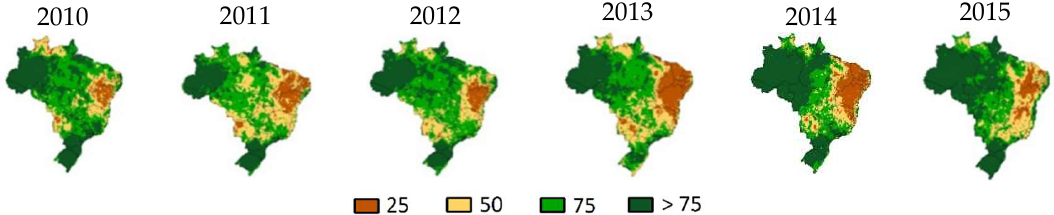
Figure 8. Yearly average spatial-temporal distribution of the soil water storage [mm] derived from MUSA model at 1 m depth in the Brazilian semiarid during representative years 2010 to 2015.